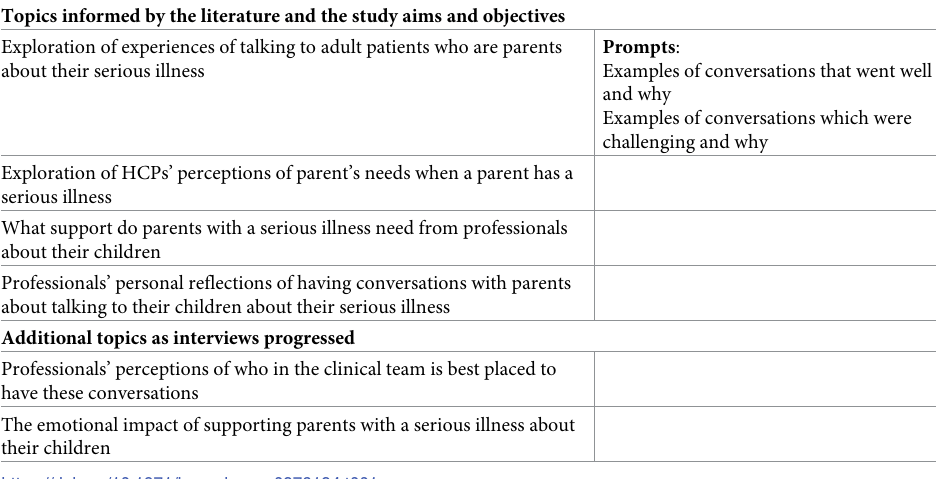
Table 1. Semi-structured interview